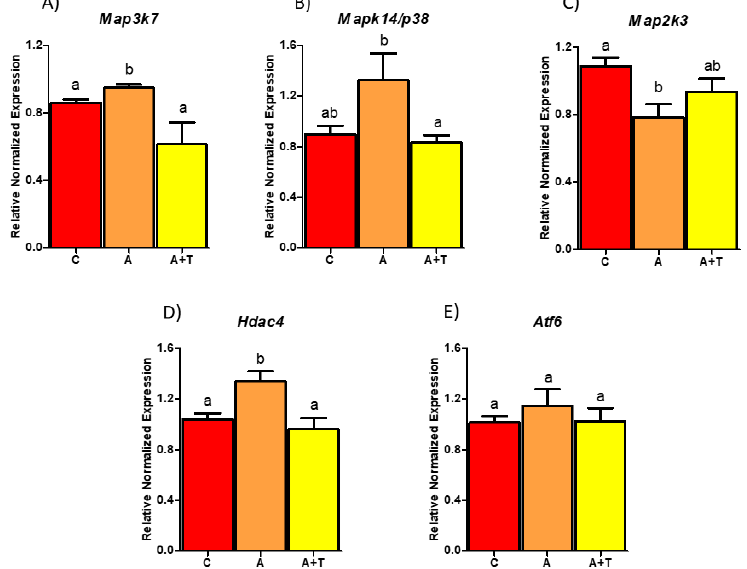
Figure 4. Renin–angiotensin system (RAS) overexpression differentially regulates genes related to inflammation and cell stress in 3T3-L1 adipocytes. ( A , B ) RAS overactivation induces mitogen-activated protein kinase kinase kinase 7 ( Map3k7 ), mitogen-activated protein kinase 14 ( Mapk14 / p38 ) in Ang II treated group compared to control group, whereas Ang II treatment along with telmisartan